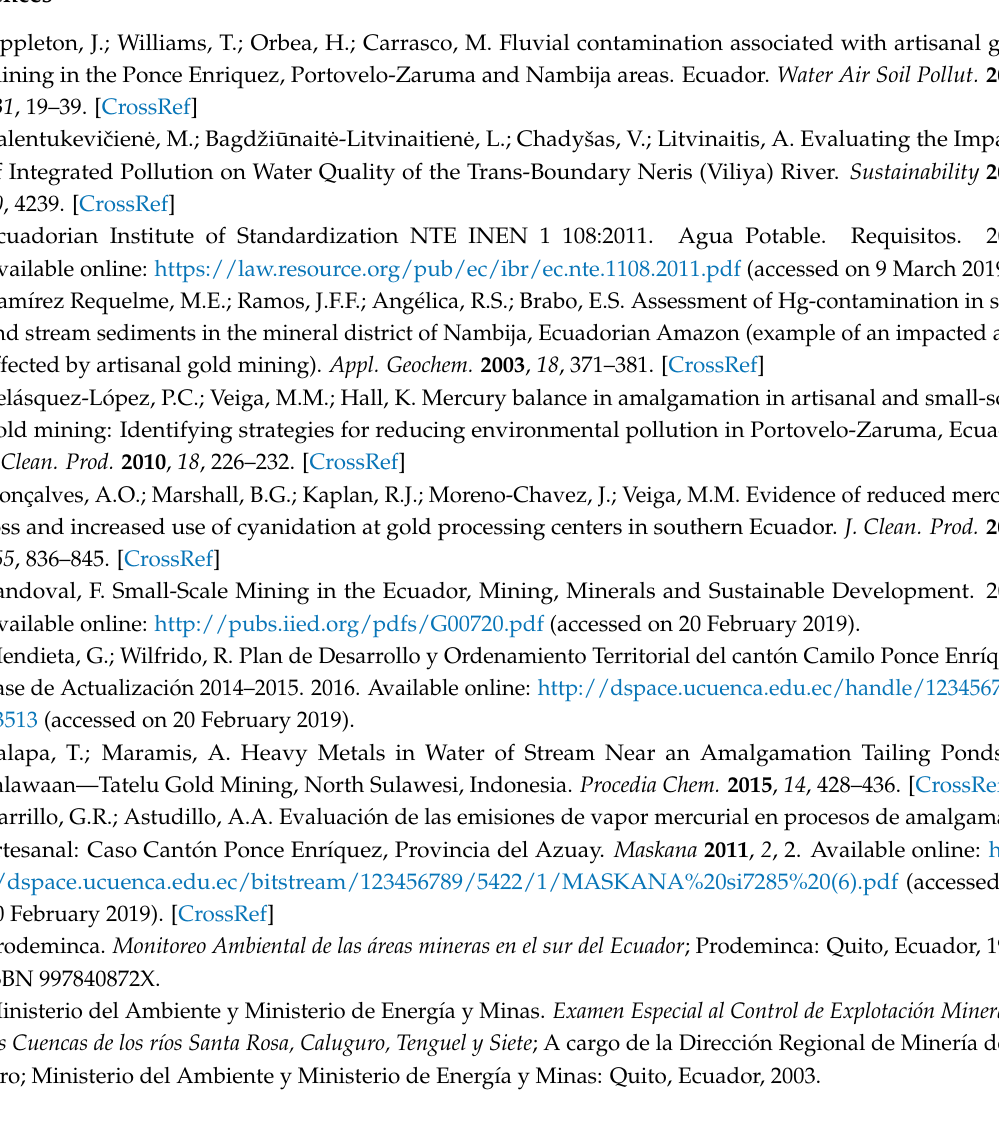
Table S1: Full ICP-MS results at Ferm í n River, Table S2: Full ICP-MS results at Ferm í n Norte River, Table S3: Full ICP-MS results at Guanache River, Table S4: Full ICP-MS results at Villa River, Table S5: Full ICP-MS results at Siete